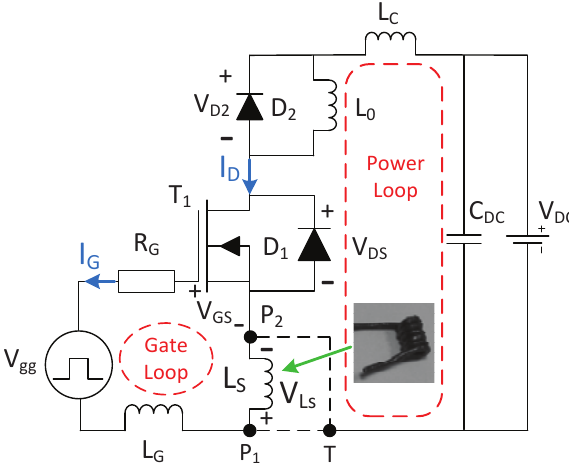
Figure 2. The schematic circuit of the double-pulse